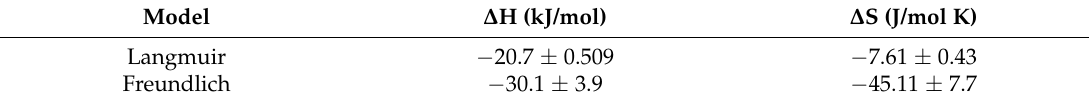
Table 10. Thermodynamics parameters for ammonia adsorption over CAG